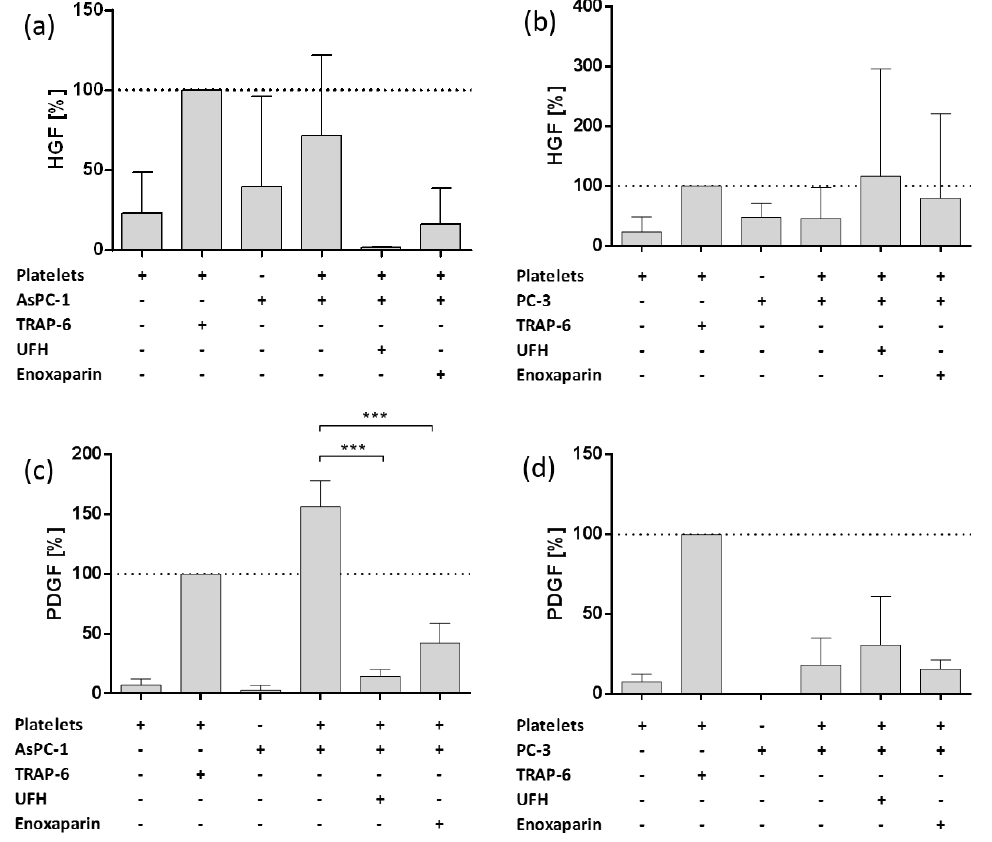
Figure 2. Impact of heparin on platelet derived HGF and PDGF release. ( a ) Impact of UFH or Enoxaparin on AsPC-1 cell induced HGF release from platelets. ( b ) Impact of UFH or enoxaparin on PC-3 cell induced HGF release from platelets. ( c ) Impact of UFH or enoxaparin on AsPC-1 cell induced PDGF release from platelets. ( d ) Impact of UFH or enoxaparin on PC-3 cell induced PDGF release from platelets. Data are means of at least n = 3 ( ± SD), asterisks indicate statistical significance: *** p ≤